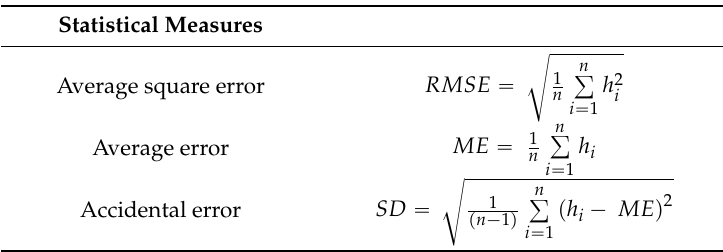
Table 1. Accuracy measures for embankments DEM.